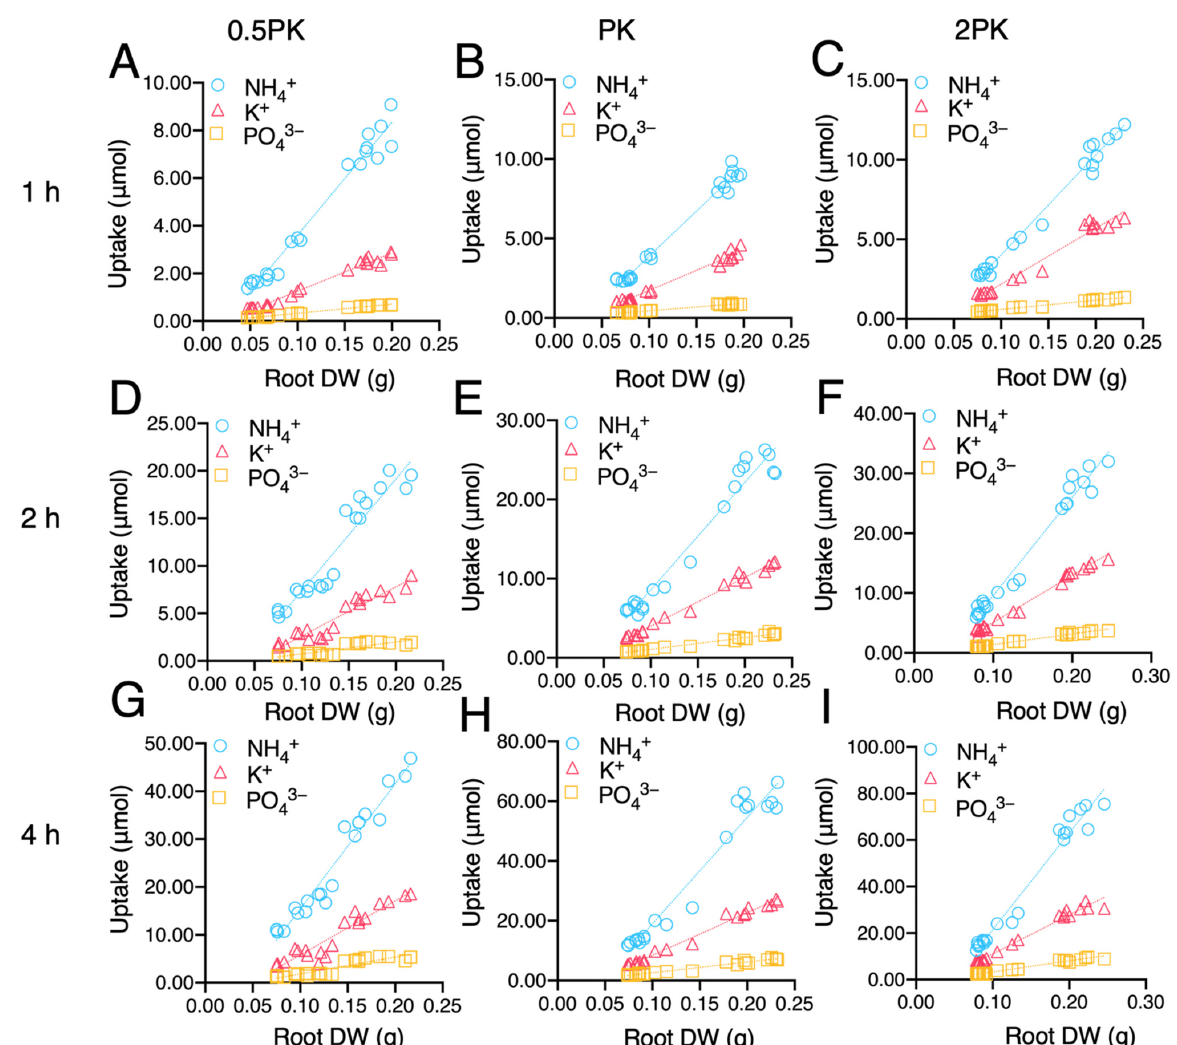
Figure 4. Relative expression level of N, P, and K transporter genes in roots of WT, OSA1 -oxs, and osa1 mutants. Four-week-old rice plants were cultured in IRRI nutrient solution containing 2.0 mM NH 4+ and half (0.5PK), normal (PK), and twofold (2PK) concentrations of P and K for 4 h. ( A , B ) Relative expression levels of AMT1;1 and AMT1;2 . ( C , D ) Relative expression levels of OsPHT1;1 and OsPTH1;2 . ( E , F ) Relative expression levels of HAK1 and HAK5 . Values are presented as the means ± SD ( n = 3). Different letters indicate significant differences at p < 0.05 according to two-way ANOVA with Tukey’s multiple-comparisons test.